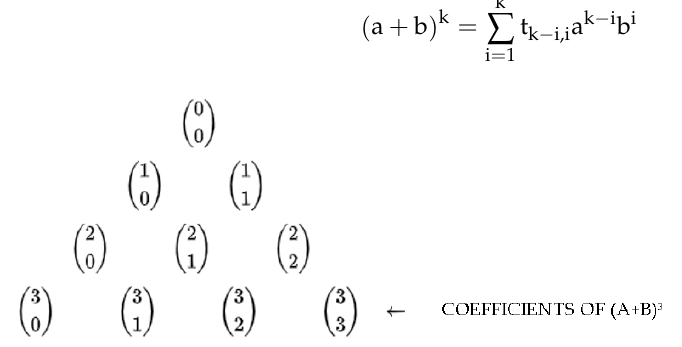
Figure 3. Pascal’s triangle with terms replaced by its combinatory form (adapted from [42]).